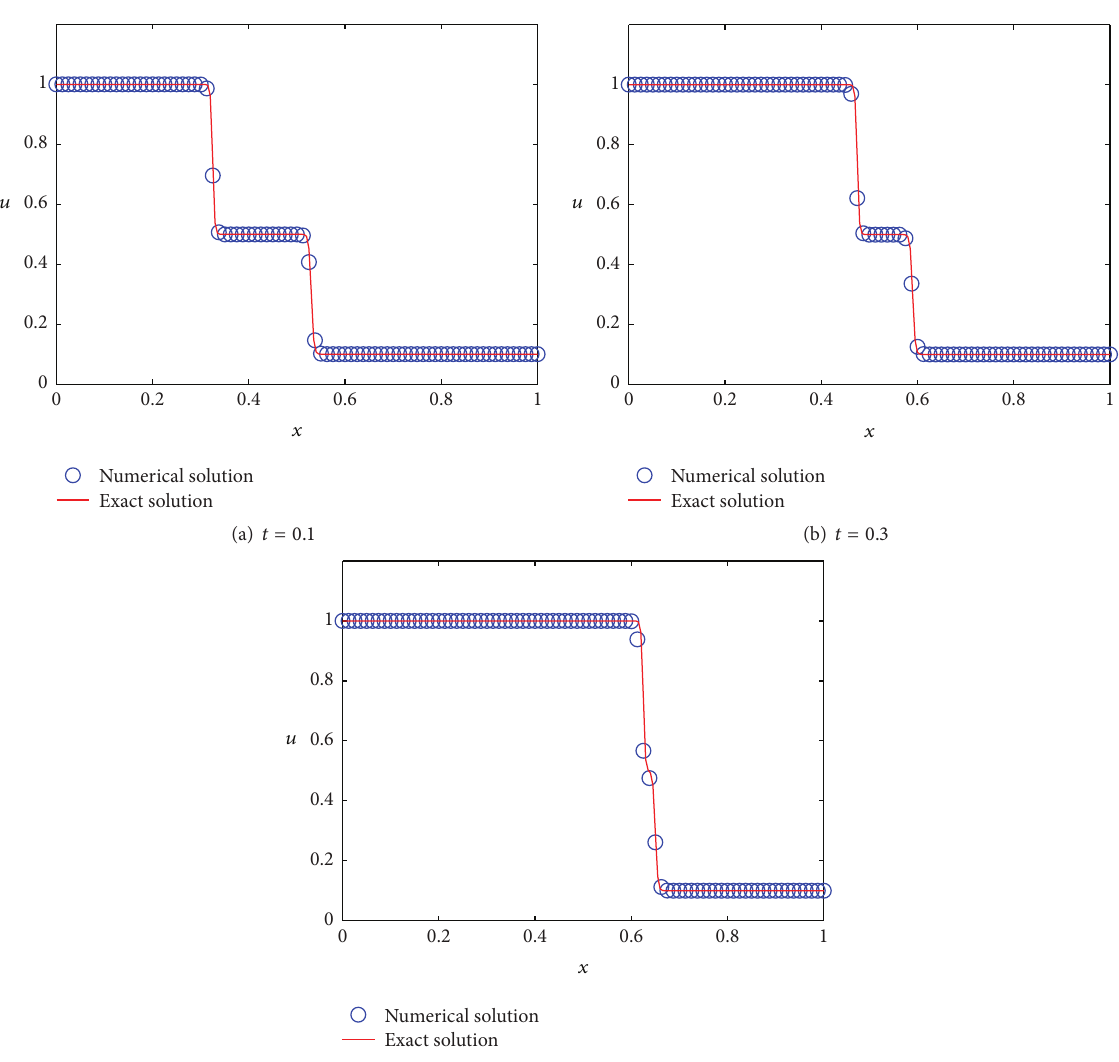
Figure 3: Comparison of VMEFG method with filter and exact solution at 𝑡 = 0.1 , 0.3, and